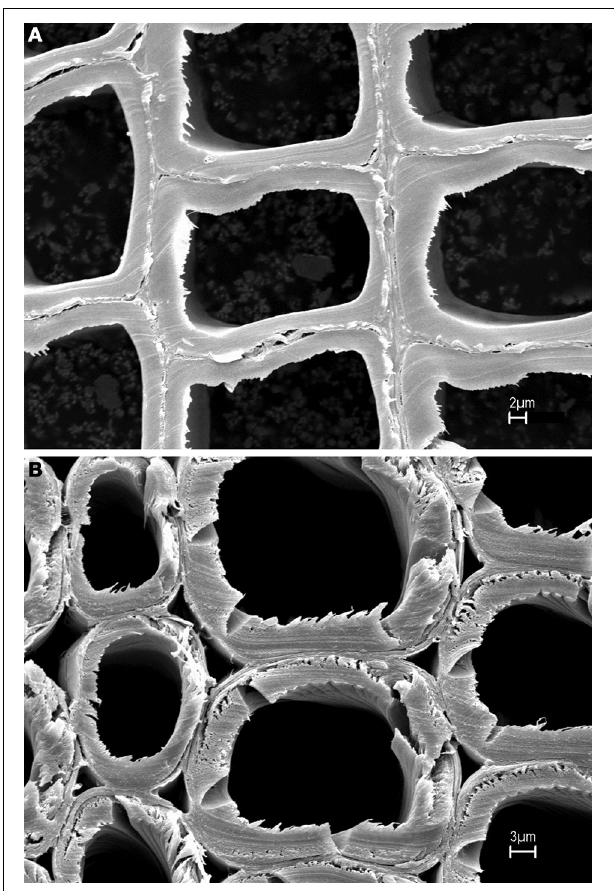
FIGURE 1 | SEMs of normal (A) and compression wood (B).